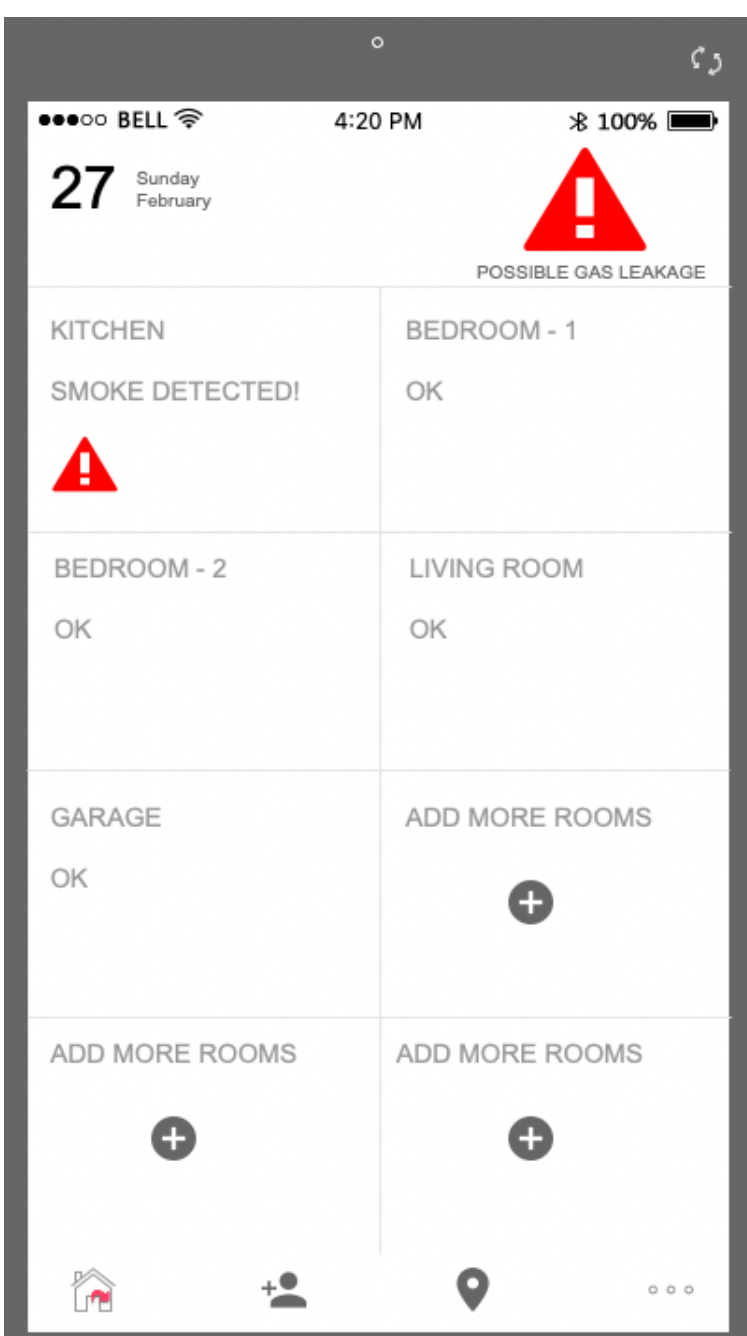
Figure 9. The developed mobile